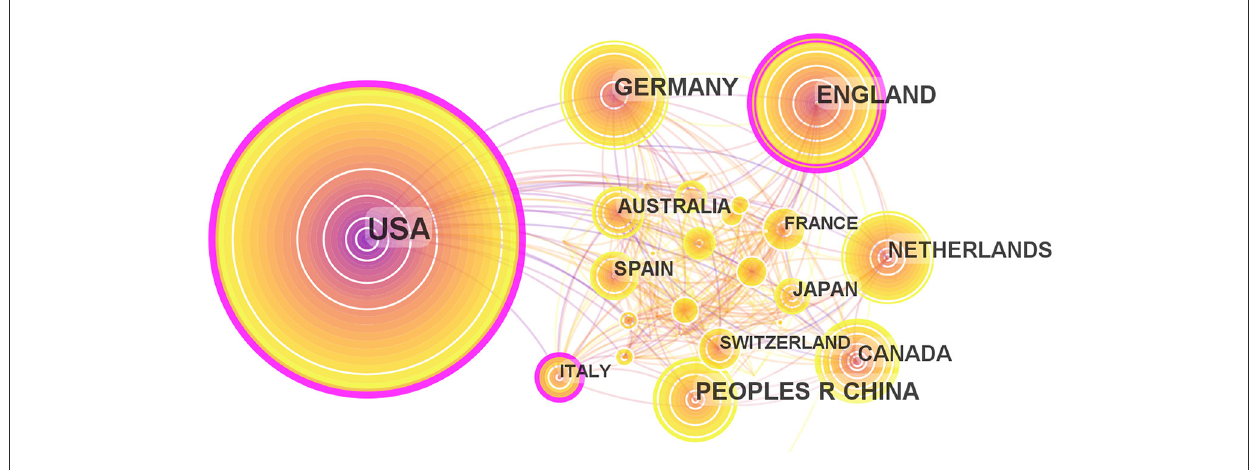
FIGURE4 Map of countries researching ADHD neuroimaging from 1992 to 2022.